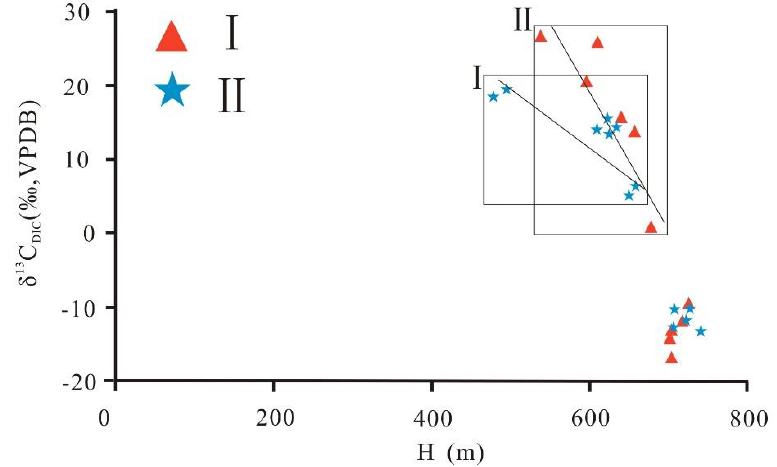
Figure 6. Relationship between δ 13 C DIC values of dissolved inorganic carbon (DIC) and hydraulic head (H) level in the CBM co-produced water.